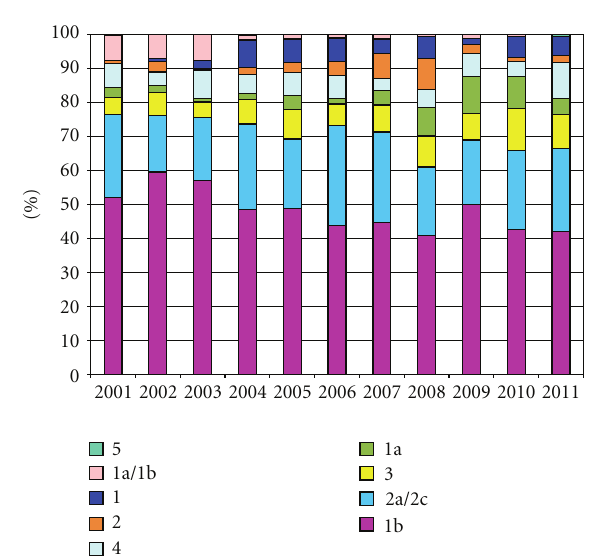
Figure 1: Dynamic distributions of HCV genotypes from January 2001 to December 2011. The Cobas AmpliPrep/Cobas